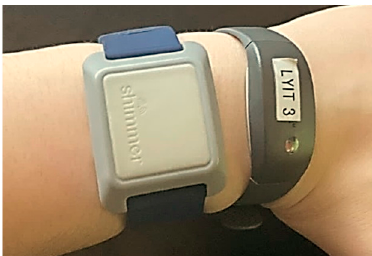
Figure 1. Verisense (left) and Actiwatch 2 (right) wrist-worn devices as worn by a